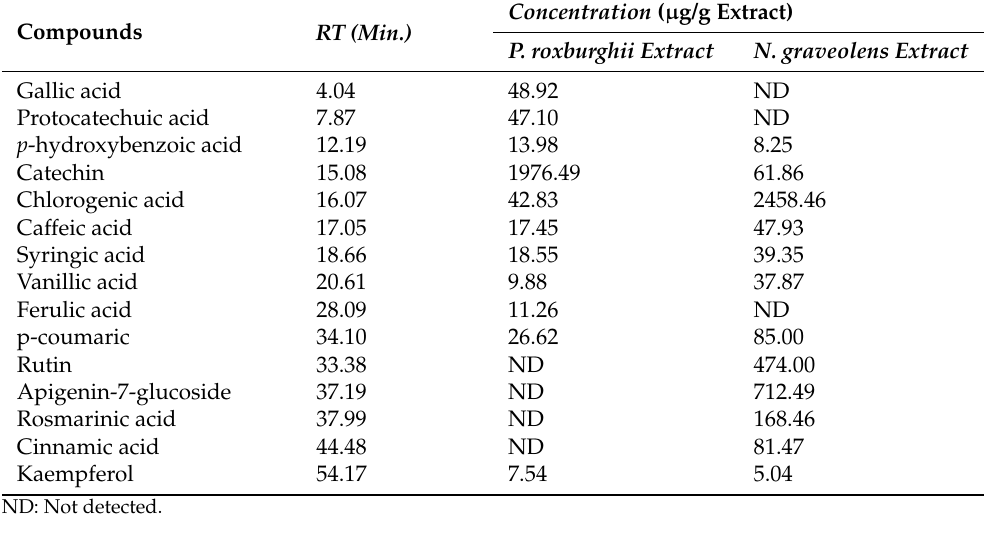
Table 3. Phenolic compounds of the P. roxburghii branch and N. graveolens extracts.